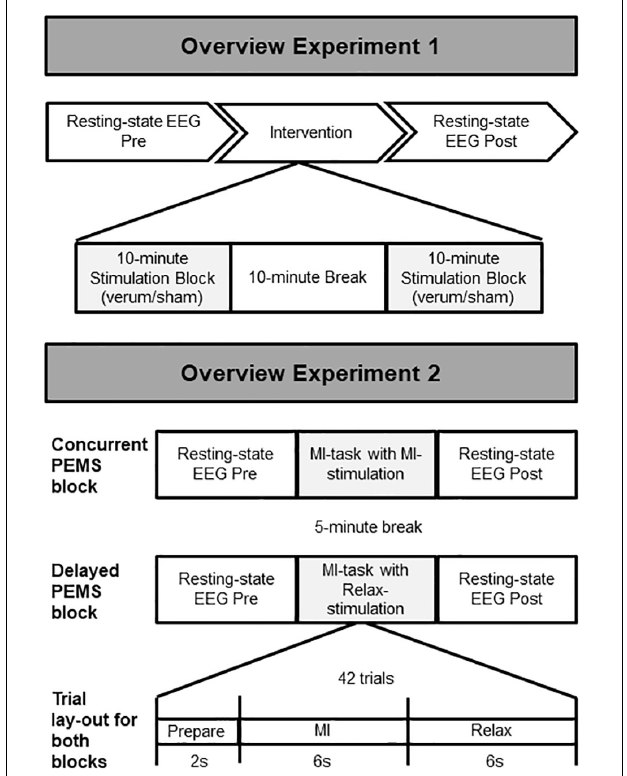
FIGURE 1 | Overview of the study procedure. Experiment 1: Two stimulation conditions (verum and sham) were delivered during two separate stimulation sessions (session 1 = verum, session 2 = sham). The same overall procedure was followed for each session, starting with 5-min recording of resting-state EEG, followed by a total of 20 min of PEMS (verum) or sham stimulation, and finally another 5-min recording of resting-state EEG. Experiment 2: Two stimulation conditions (concurrent and delayed PEMS) were delivered during a single session, in two separate blocks. Order of stimulation conditions was randomized. In the concurrent PEMS condition, PEMS was applied during the MI phase of the trial. In the delayed PEMS condition, PEMS was applied during the Relax phase of the